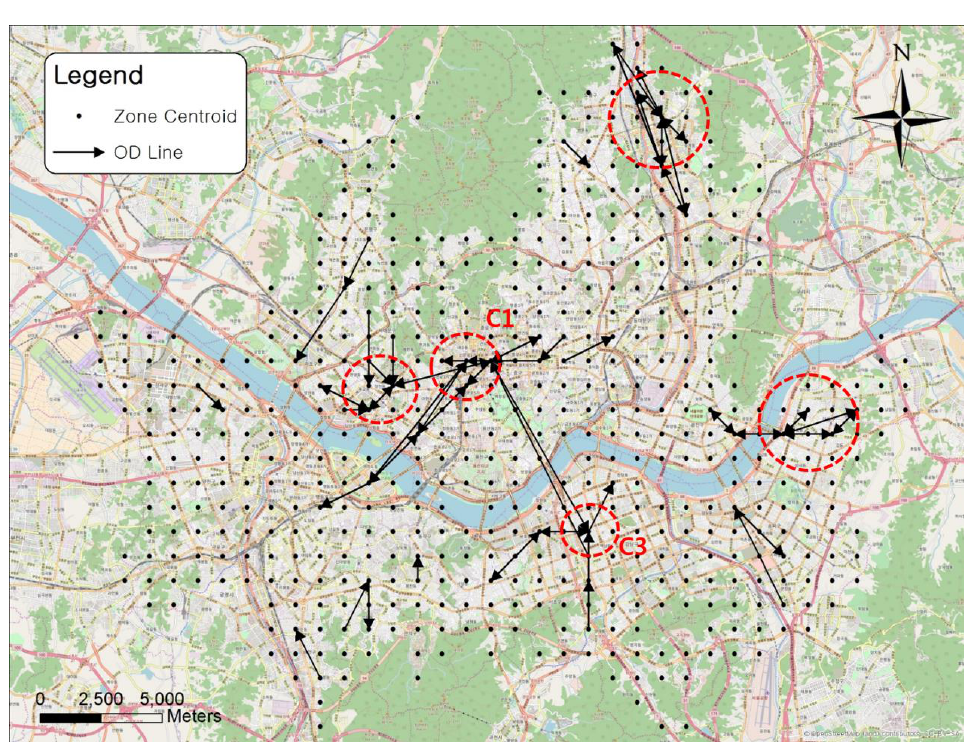
Figure 8. [Off-peak] Service disparity